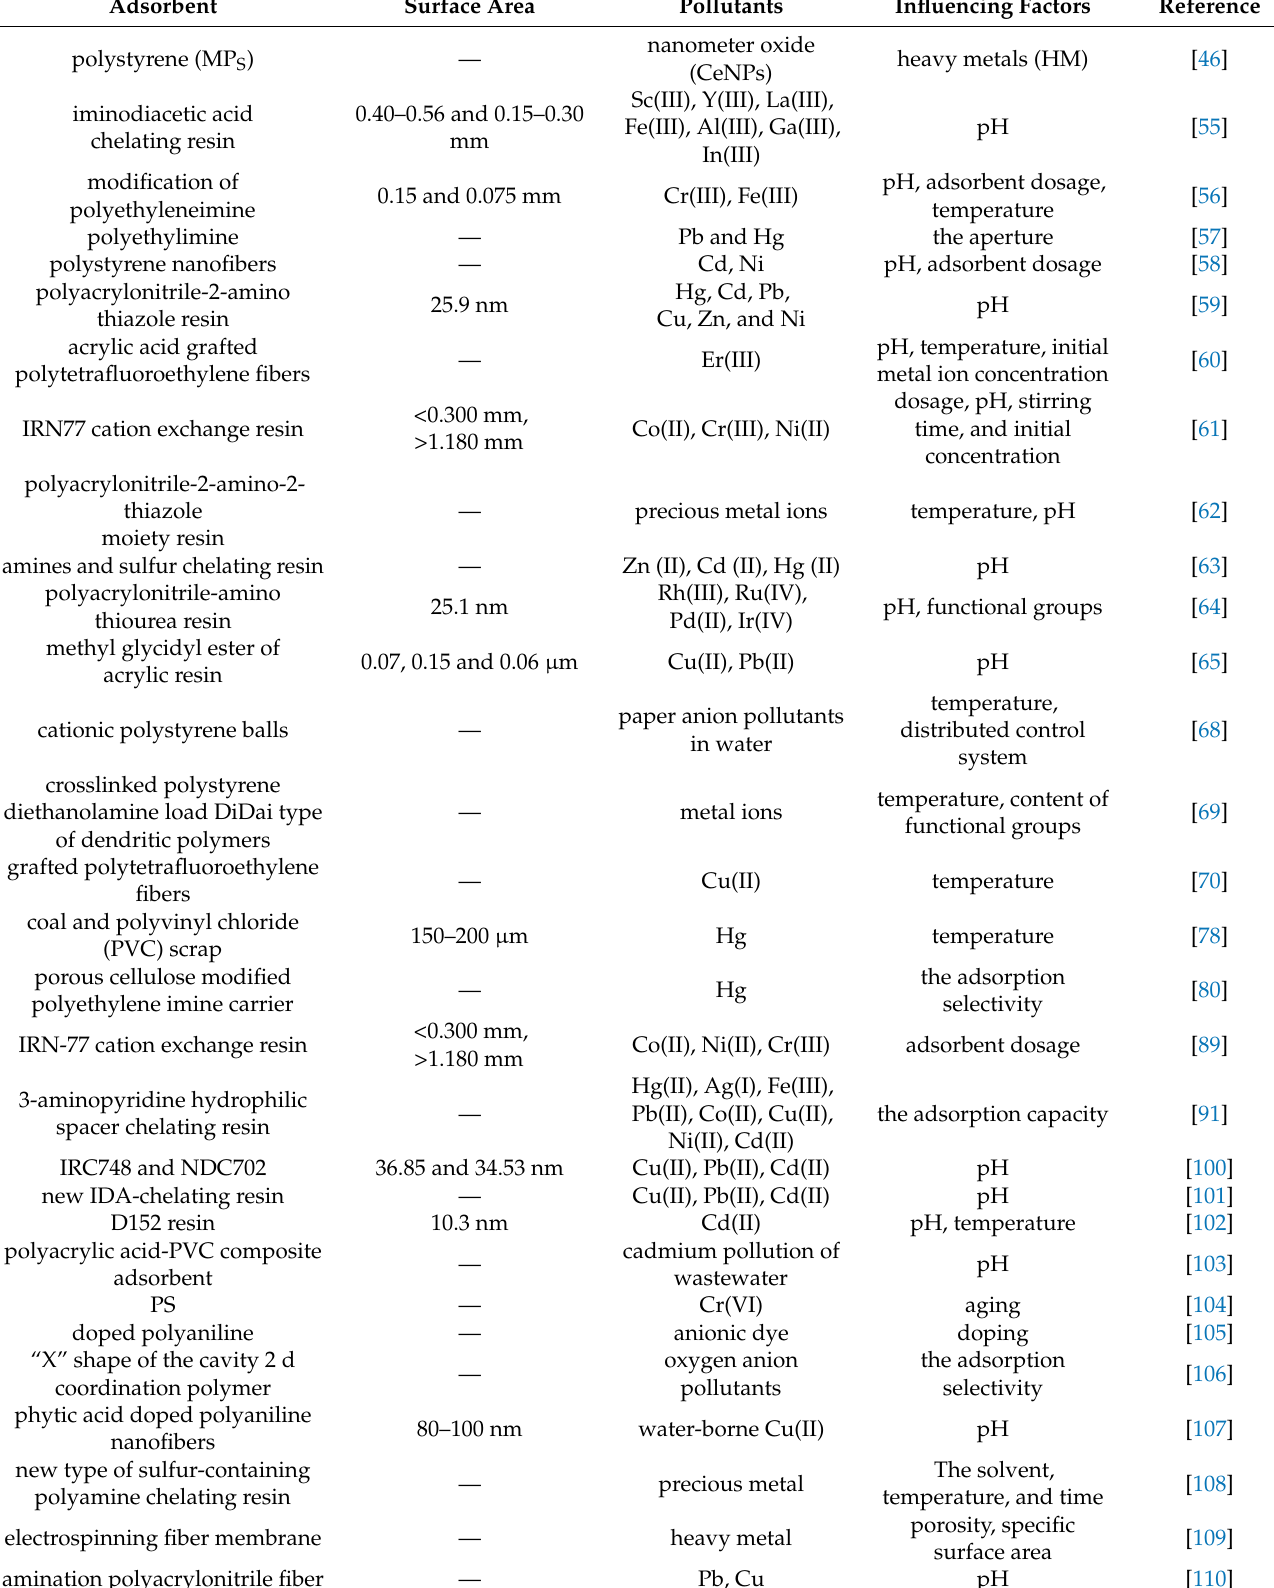
Table 2. Adsorption of inorganic